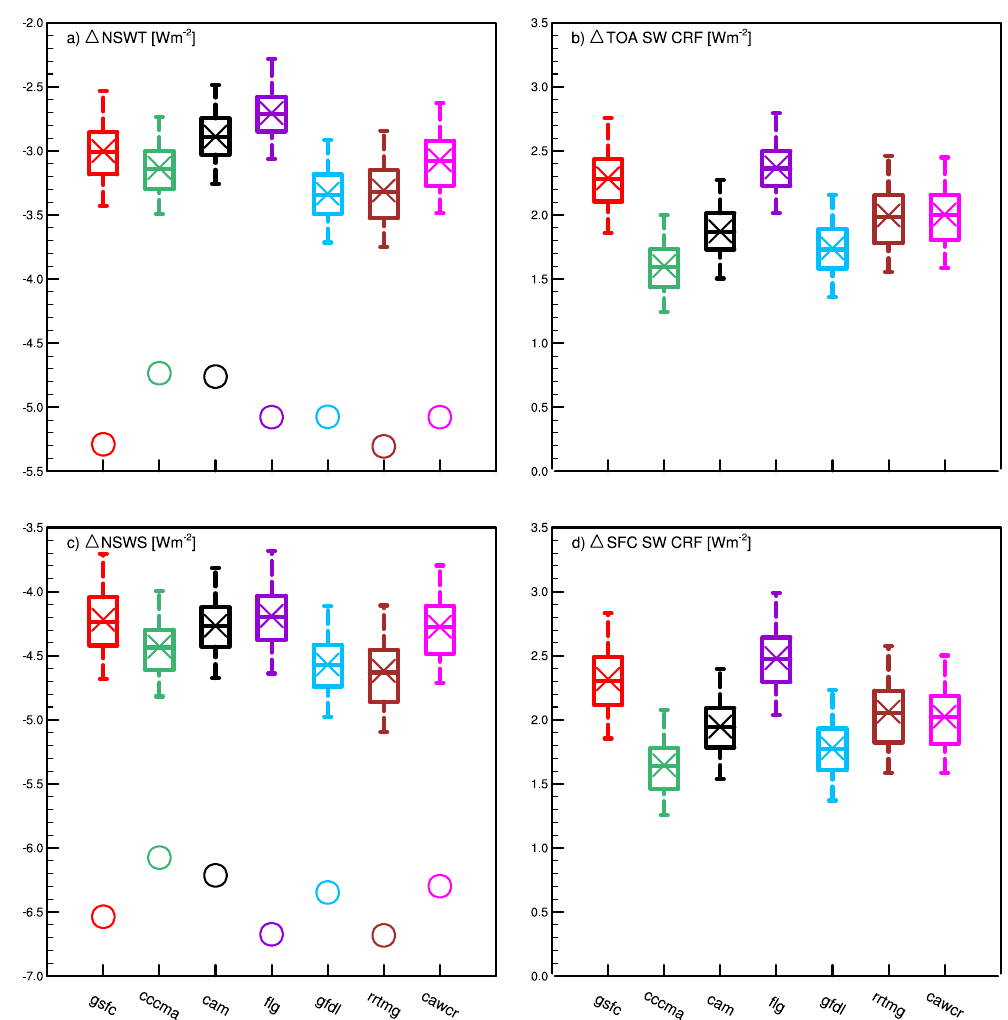
Fig. 4. Global mean aerosol direct radiative effects on TOA (top) and surface (bottom) SW all-sky net fluxes with clear-sky values (circle, a , c ) and CRFs ( b , d ) on average for January and July 2004 using the MISR climatological aerosol distribution. The box plot shows the minimum, 25th percentile, median, 75th percentile, and maximum values among the 64 cloud members for each radiation transfer scheme, while the X within each box depicts the ensemble